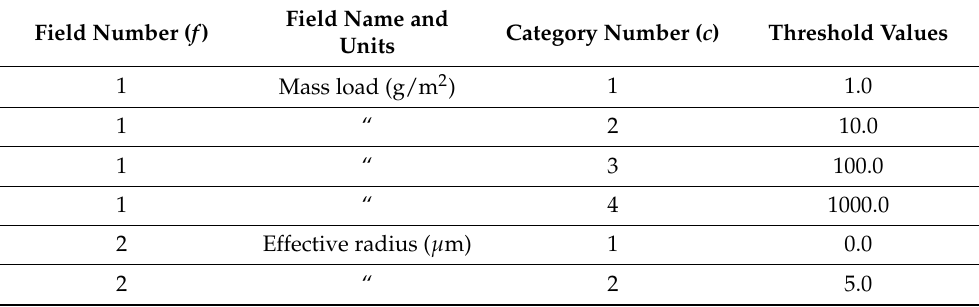
Table 1. A description of the object denoted ϕ fc in Section 2.3. This object lists the field thresholds used to compute the multi-categorical Brier scores as a function of field index, f , and category index, c . These values are the same as those used in previous studies and were chosen to broadly represent the different field values that are possible, both in retrieved and simulated